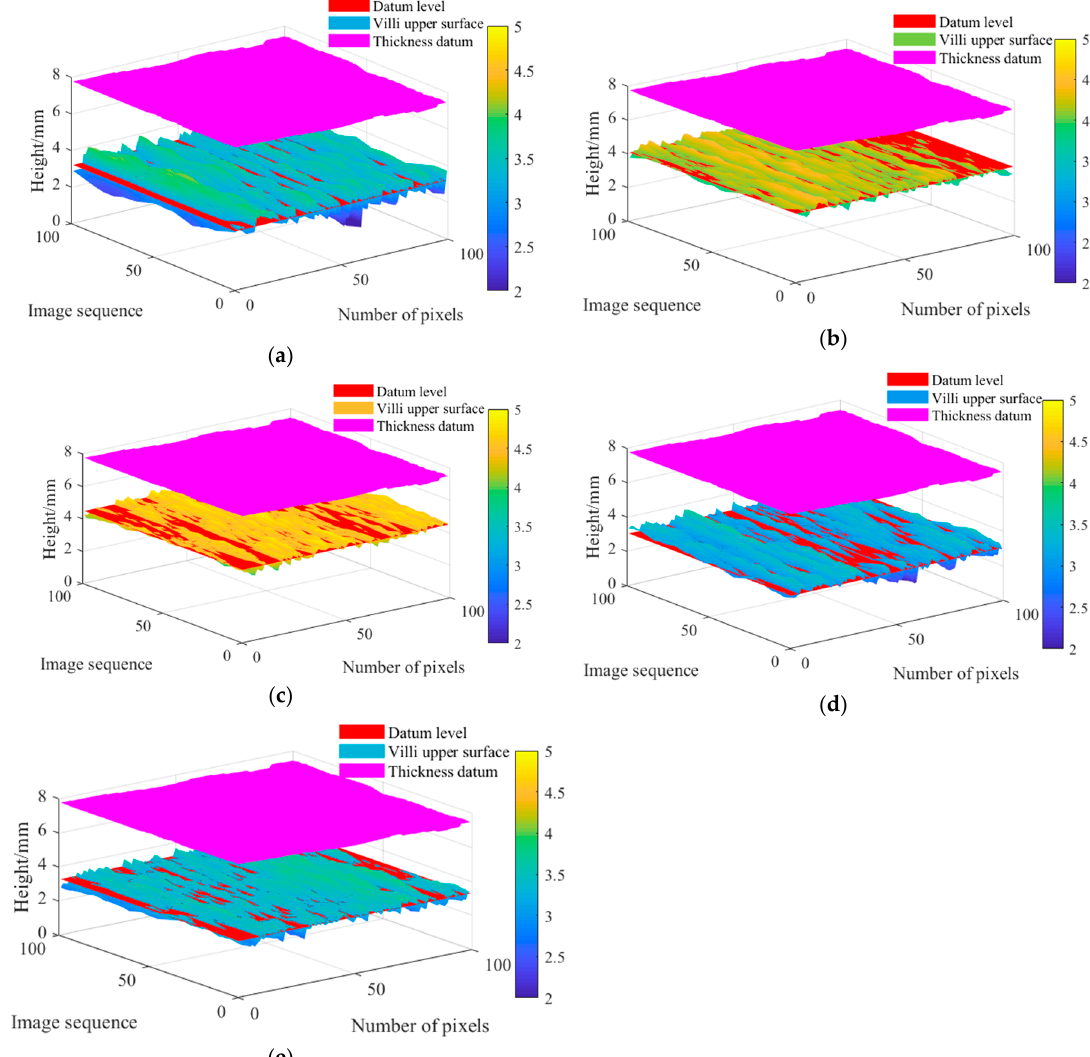
Figure 7. 3D reconstruction of the upper surface of the fabric samples. ( a ) 3D reconstruction of the surface of sample a. ( b ) 3D reconstruction of the surface of sample b. ( c ) 3D reconstruction of the surface of sample c. ( d ) 3D reconstruction of the surface of sample d. ( e ) 3D reconstruction of the surface of sample e.